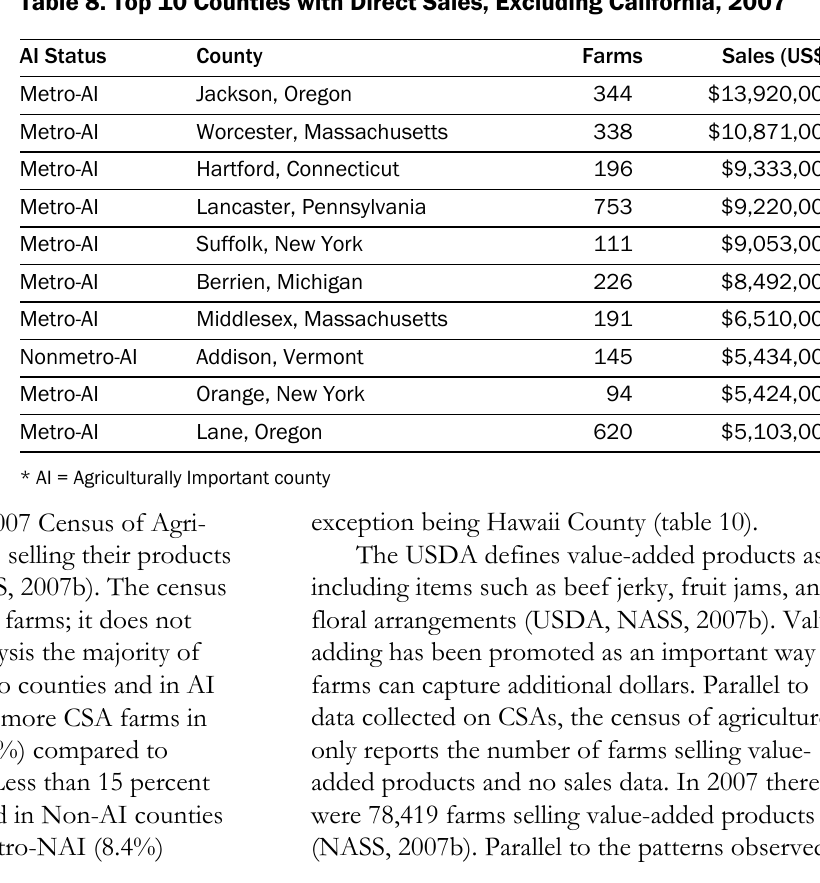
Table 8. Top 10 Counties with Direct Sales, Excluding California, 2007